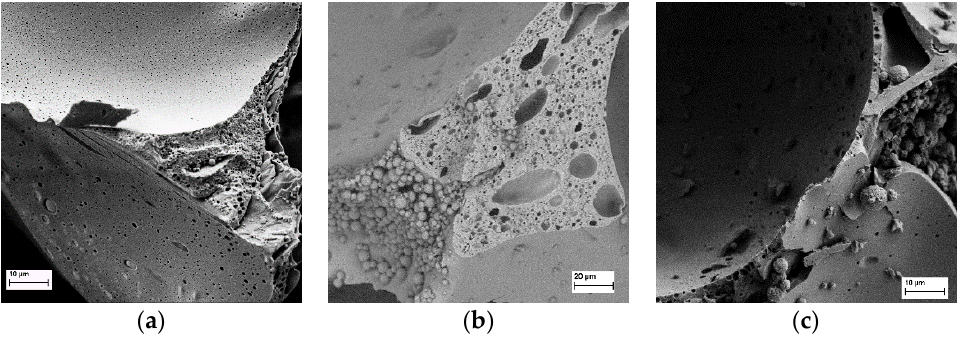
Figure 4. Photographs of ( a ) tannin foam obtained by solvent evaporation; ( b ) SDS 4 foam and ( c ) TWEEN 10